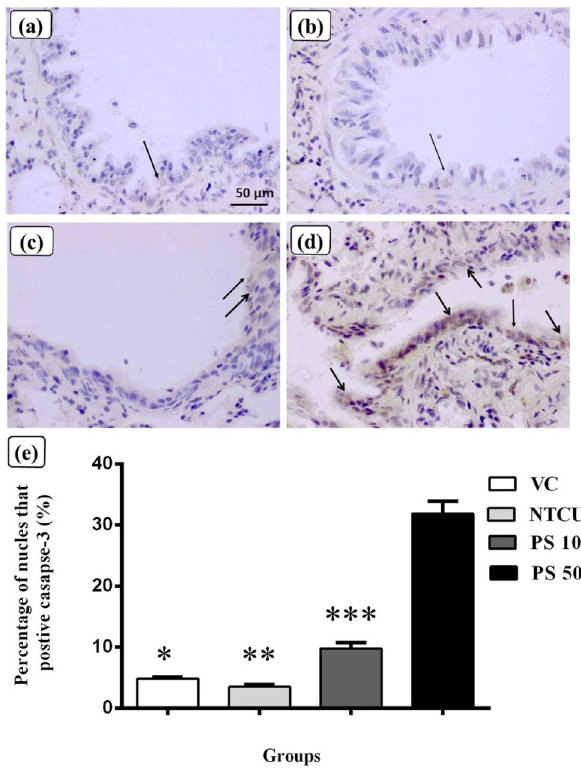
Figure 2. Immunohistochemistry was performed to detect the apoptosis marker cleaved caspase-3 in paraffin- embedded sections. Figure showed the bronchial epithelium layer of a representative mouse from each group, as shown in ( a ): VC. ( b ) shows an NTCU with fewer caspase-3 immunopositive epithelial cells (arrow). ( c ): PS 10 had an increase in caspase-3 immunopositive epithelial cells (arrows), and ( d ): PS 50 had a lot of caspase-3 immunopositive epithelial cells (arrows). ( e ) Showed the quantification of apoptosis activities using the percentage of nucleus positive for caspase-3 (immunopositive cells) per total number of nuclei at the bronchial epithelium layer. Data are presented as mean ± SEM. *there is a statistically significant between VC compared to PS 50 ( p < 0.05). **Statistically significant differences between NTCU and PS 10 and PS 50( p < 0.05). ***Statistically significant difference between PS 10 and PS 50 ( p <